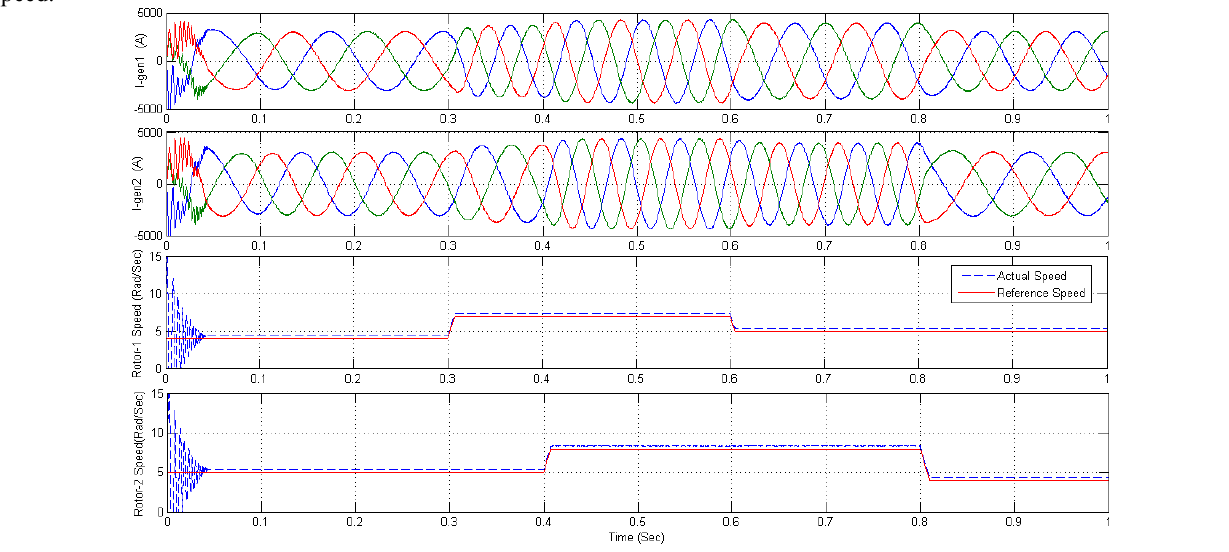
Figure 4. Performance of parallel connected units under variable